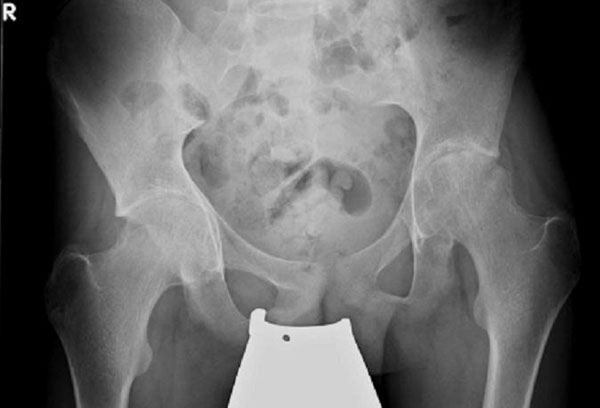
x-ray of pelvis